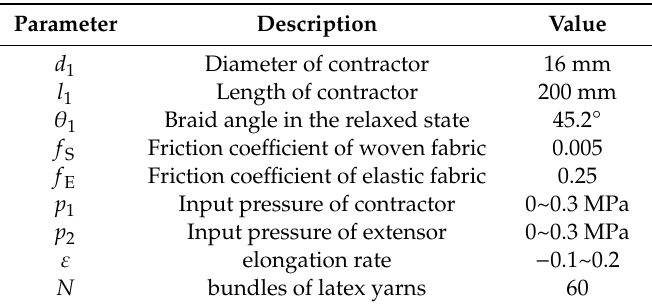
Table 2. Parameter of the soft